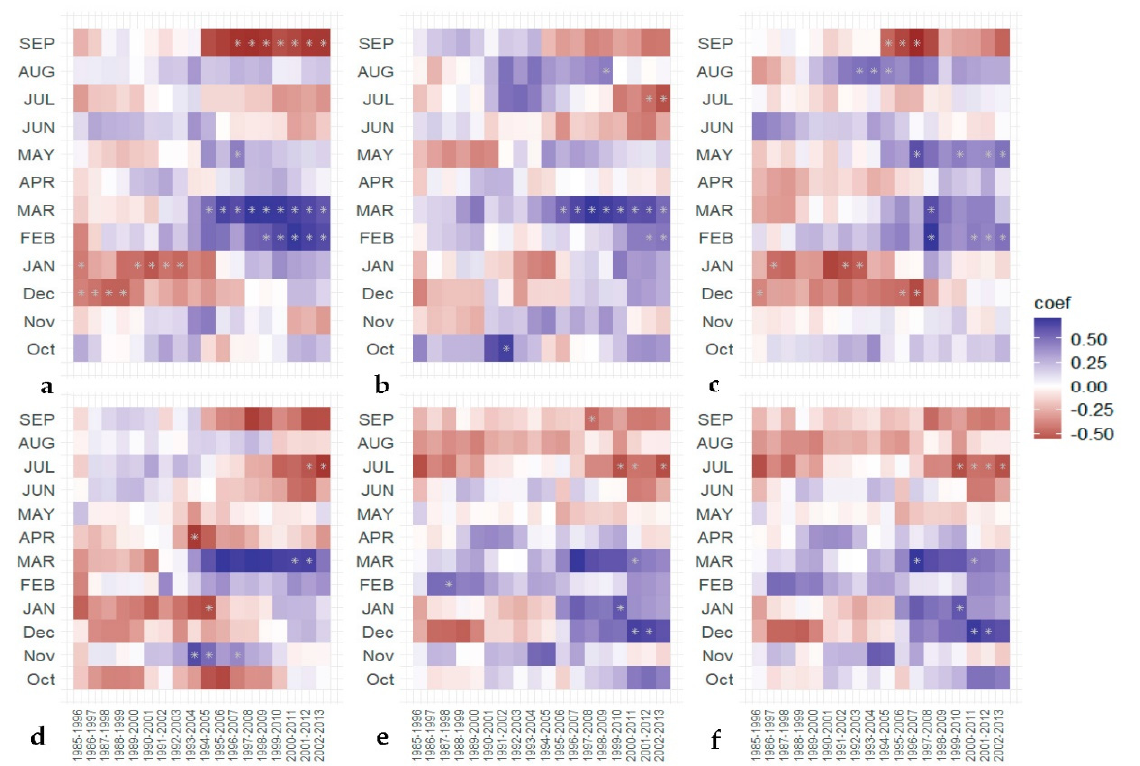
Figure 7. Matrix plots of moving correlation function relating the ring-width index (RWI) of Scots pine ( Pinus sylvestris ) provenances, representing ( a ) eastern, ( b ) central, ( c ) northern, ( d ) southern, ( e ) western locations and ( f ) all provenances, with monthly temperatures, from October in the previous year through September in the current year, over the period 1984–2013. The moving correlation is carried out in windows of 12 years, offset by 1 year. Significant correlations are denoted by asterisks (*).